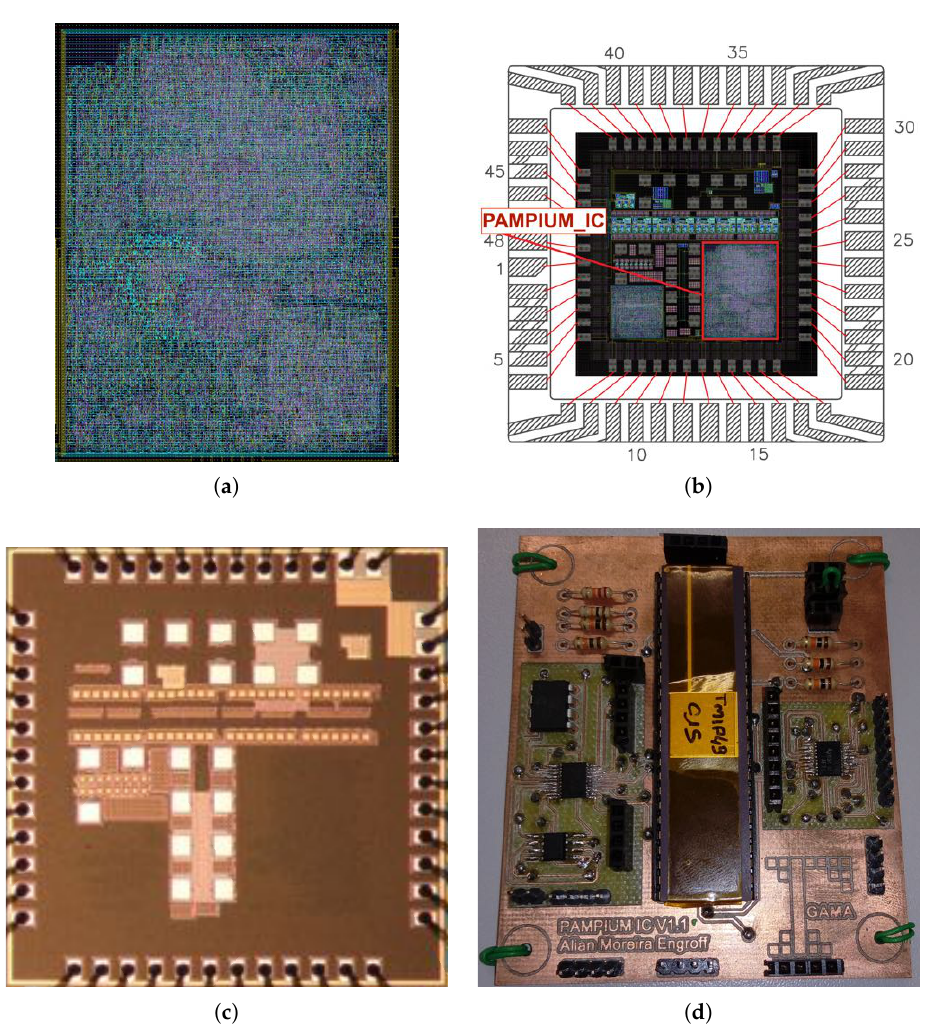
Figure 23. PAMPIUM IC layout and chip implementation. ( a ) Layout of the PAMPIUM IC. ( b ) Figure 4.1: Photos of the (a) 0.18-µm and (b) 0.13-µm CMOS process prototypes.